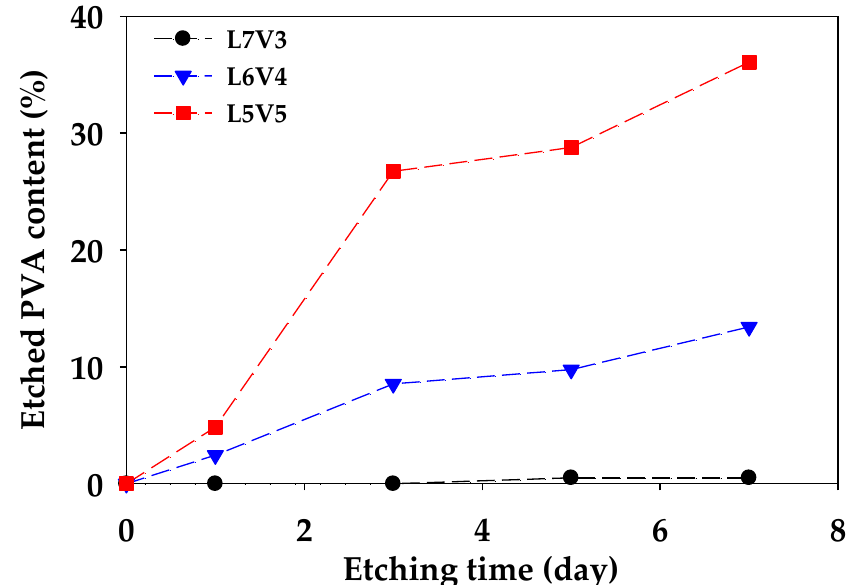
Figure 5. The etched PVA content of PLA/PVA blends, along with etching times .